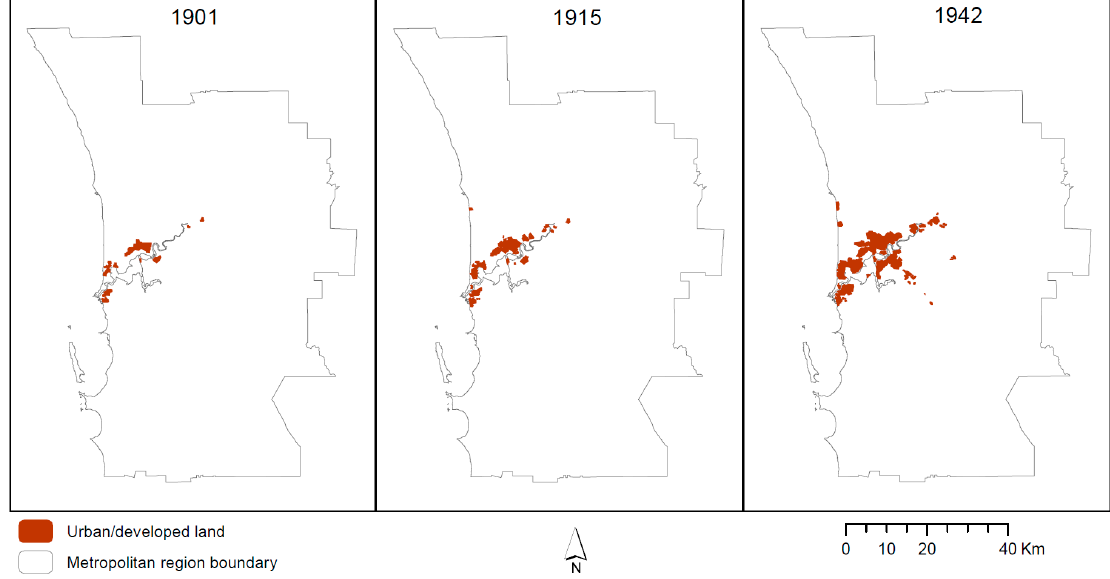
Figure 3. Footprints of Perth’s urban expansion between 1901 and 1942. Source: Made by author.